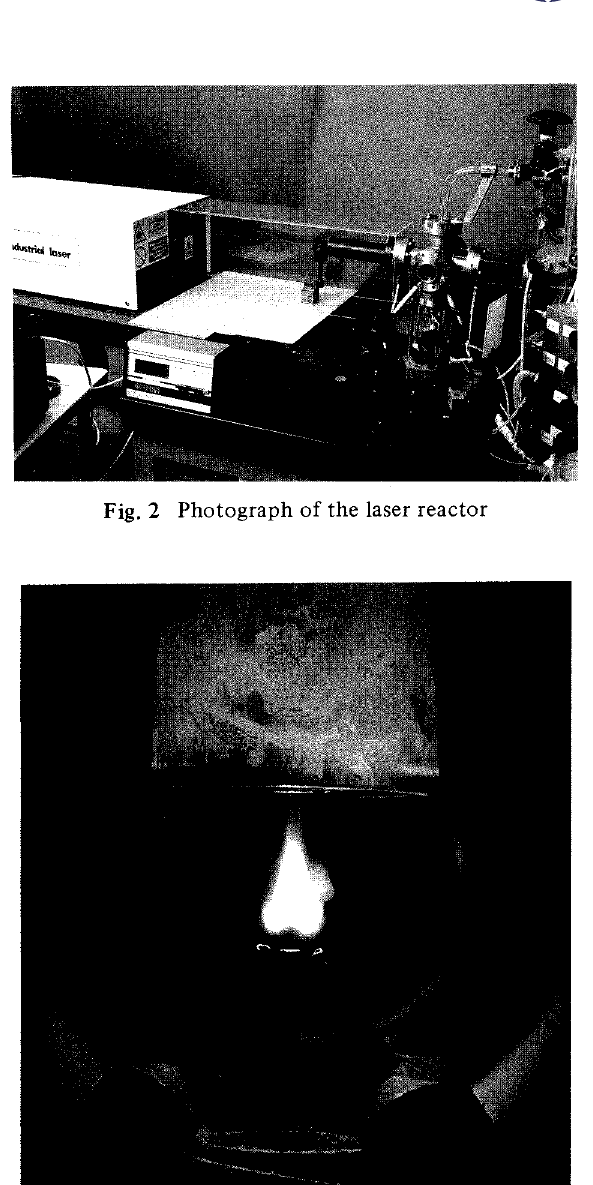
Fig. 1 Schematics of the reactor and the nozzle with the used gases